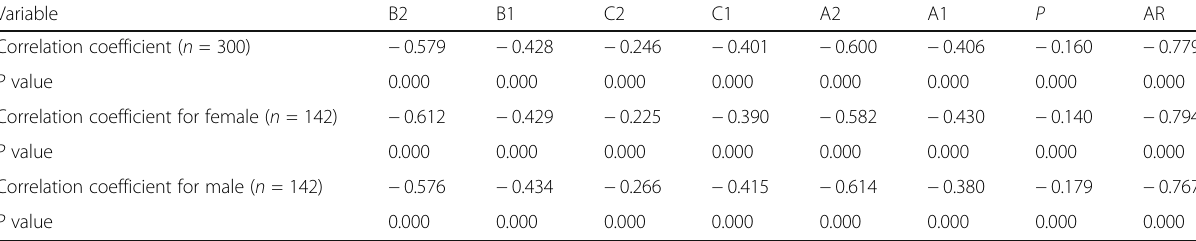
Table 1 Pearson ’ s correlation coefficient between age and the measured variables Variable